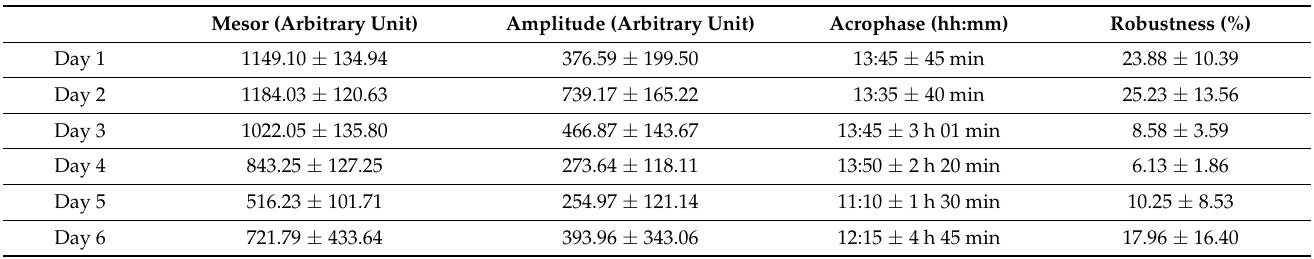
Table 1. Circadian rhythm parameters (mesor, amplitude, acrophase, and robustness of rhythm) recorded during six days of monitoring in eight Holstein calves of 30 days of life, expressed as mean ± sd in their conventional